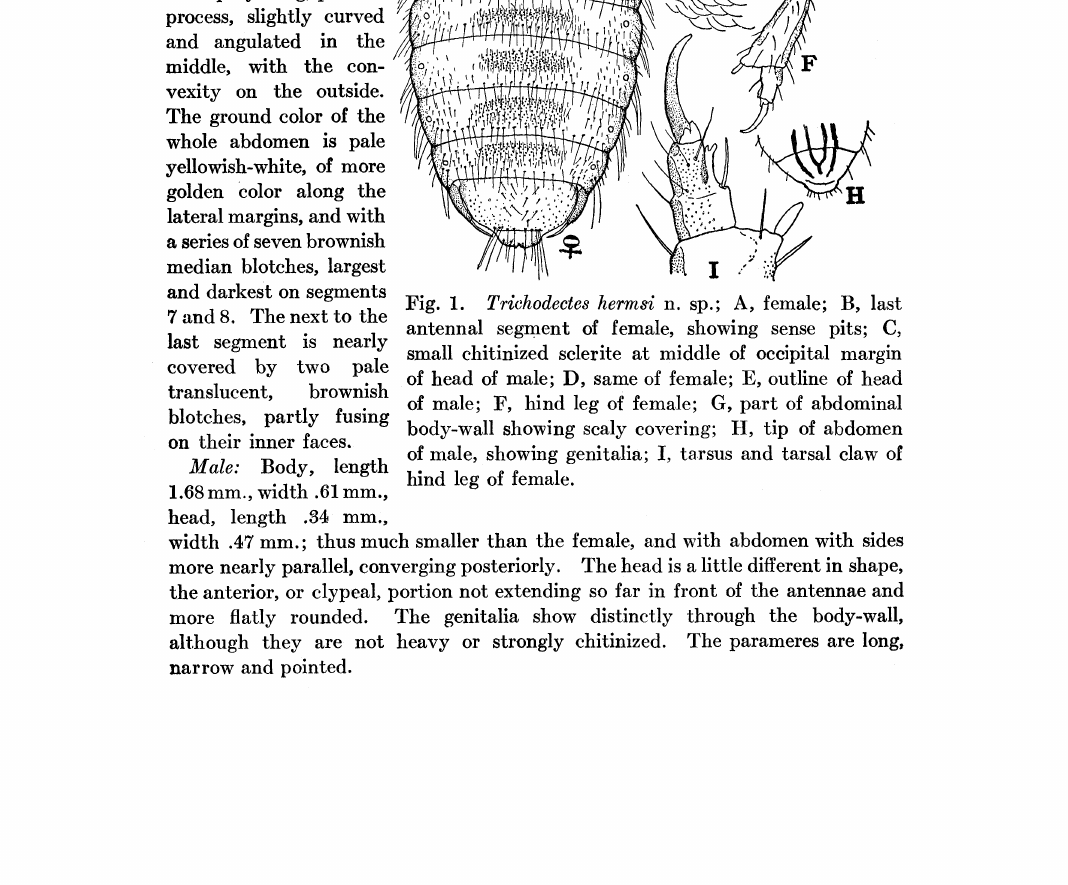
the next to last segment there is a chitinized back- ward-projecting, pointed process, slightly curved and angulated in the middle, with the con- F vexity on the outside. The ground color of the whole abdomen is pale yellowish-white, of more golden Color along the lateral margins, and with a series of seven brownish median blotches, largest I and darkest on segments Fig. 1. Trichodectes hermsi n. sp.; A, female; B, last 7 and 8. The next to the antennal segment of female, showing sense pits; C, last segment is nearly small chitinized sclerite at middle of occipital margin covered by two pale of head of male; D, same of female; E, outline of head